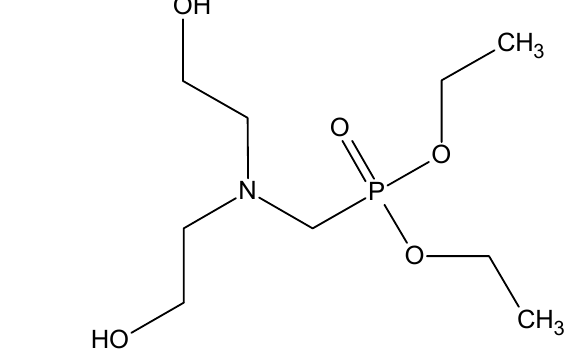
Table 9. Formulas of rigid polyurethane foams.